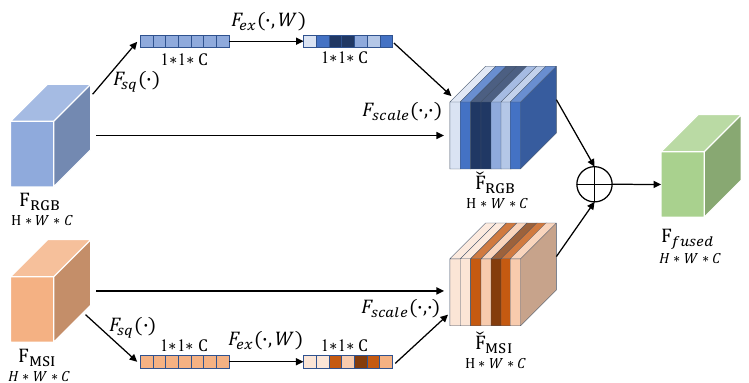
Figure 4. The process of Cross-source Feature Recalibration Module